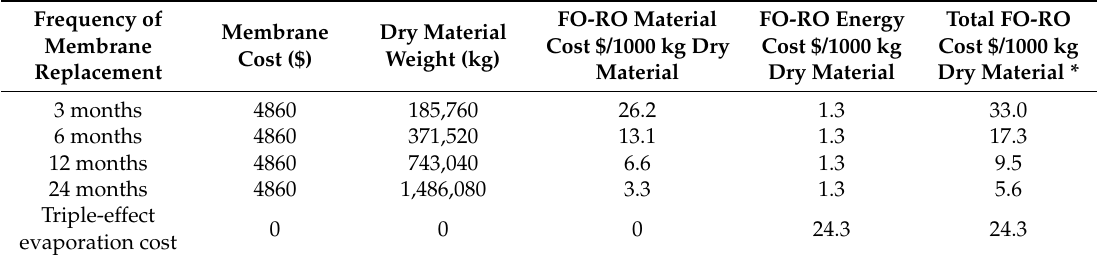
Table 2. Estimated material and energy cost using FO-RO and triple-effect evaporation